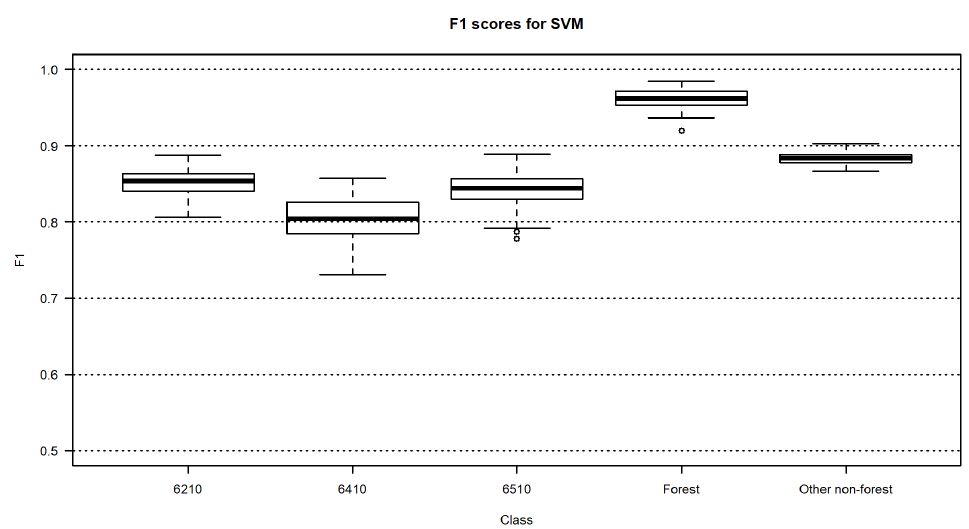
Figure 10. F1 accuracies obtained for SVM (medians are bolded).